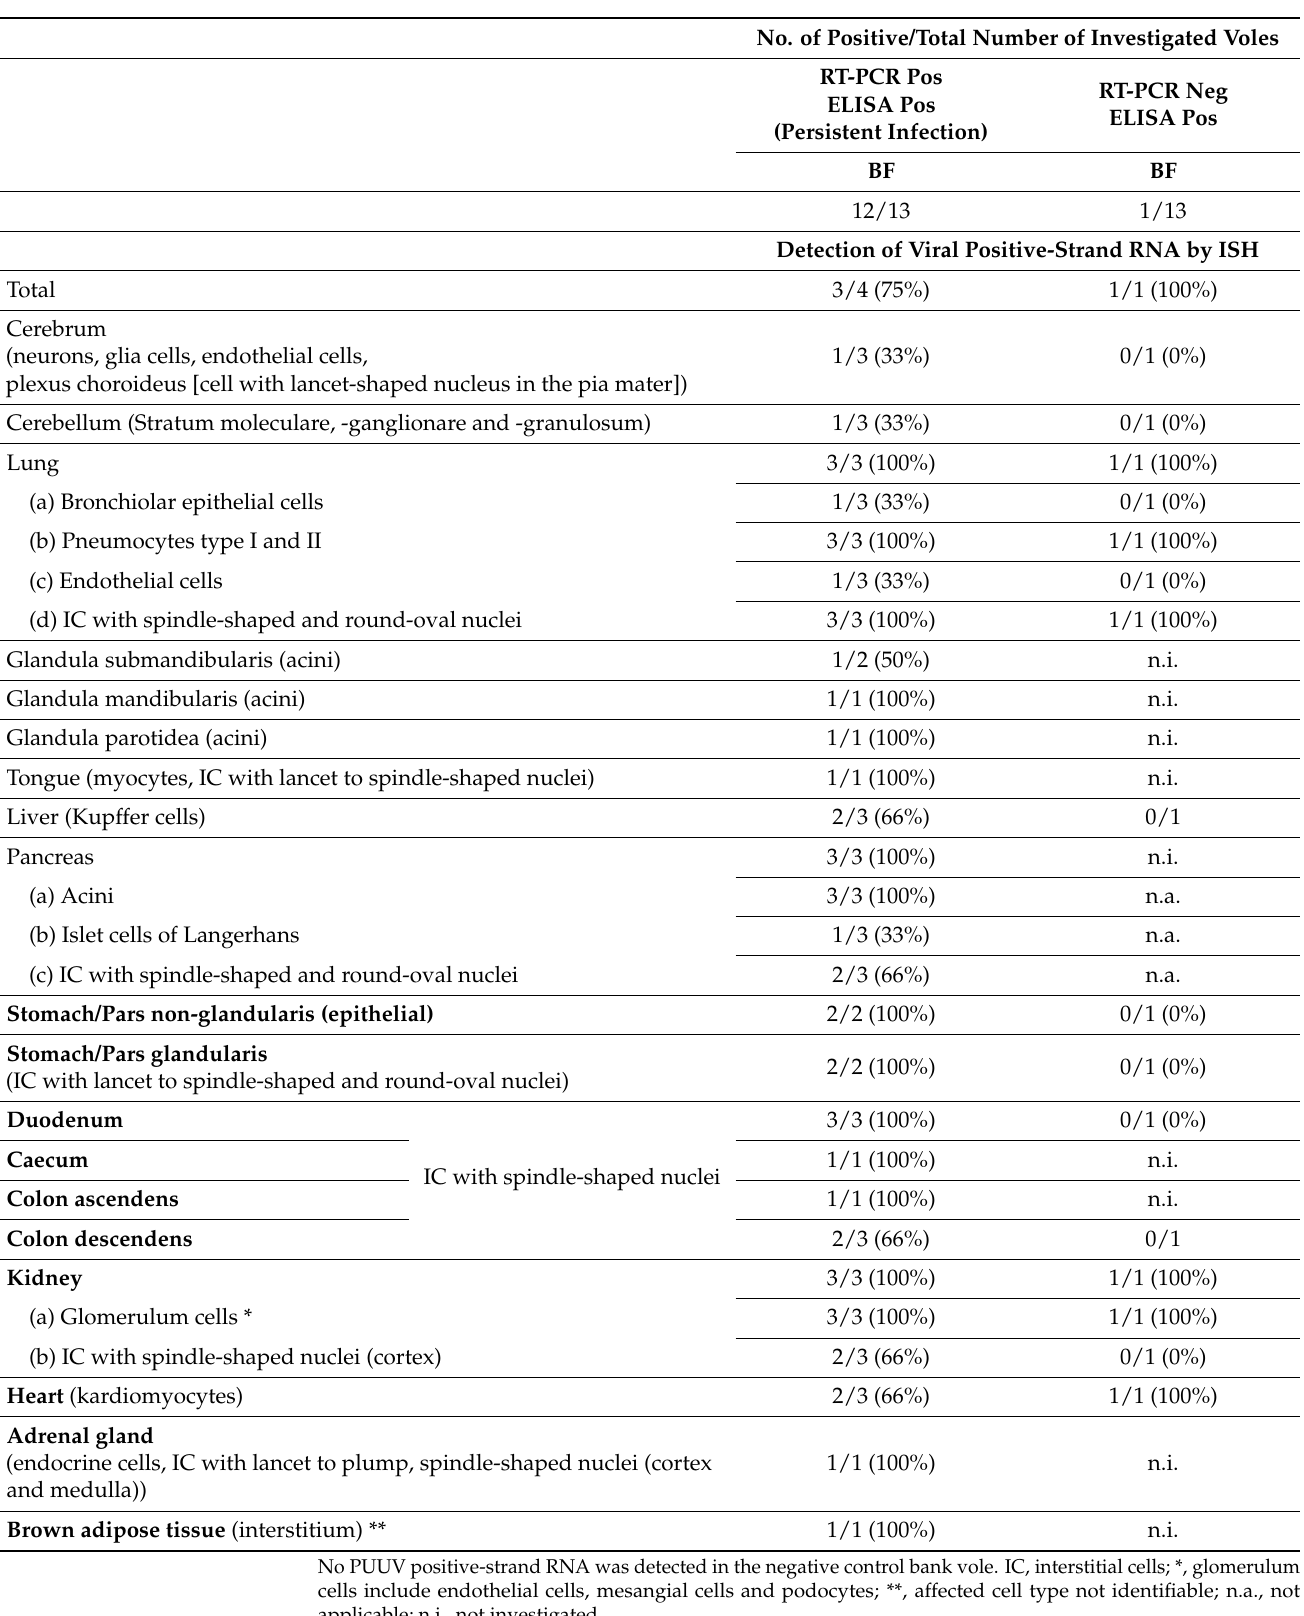
Table 2. Detection of Puumala orthohantavirus (PUUV) RNA by RT-PCR, anti-PUUV IgG antibodies by ELISA and RNAscope in situ hybridization (ISH)-based detection of positive-strand RNA in bank voles from the breeding facility